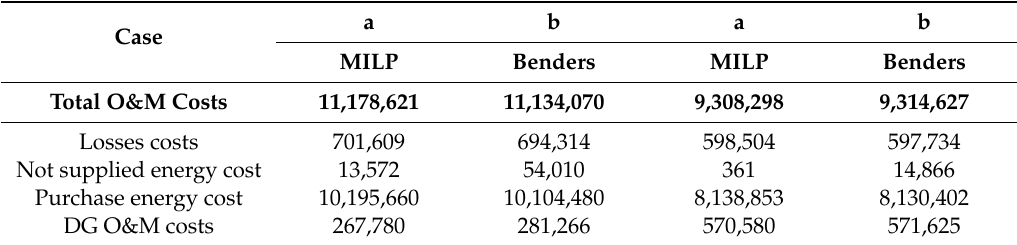
Table 9. Total O&M system costs ( € ) for 768 scenarios.